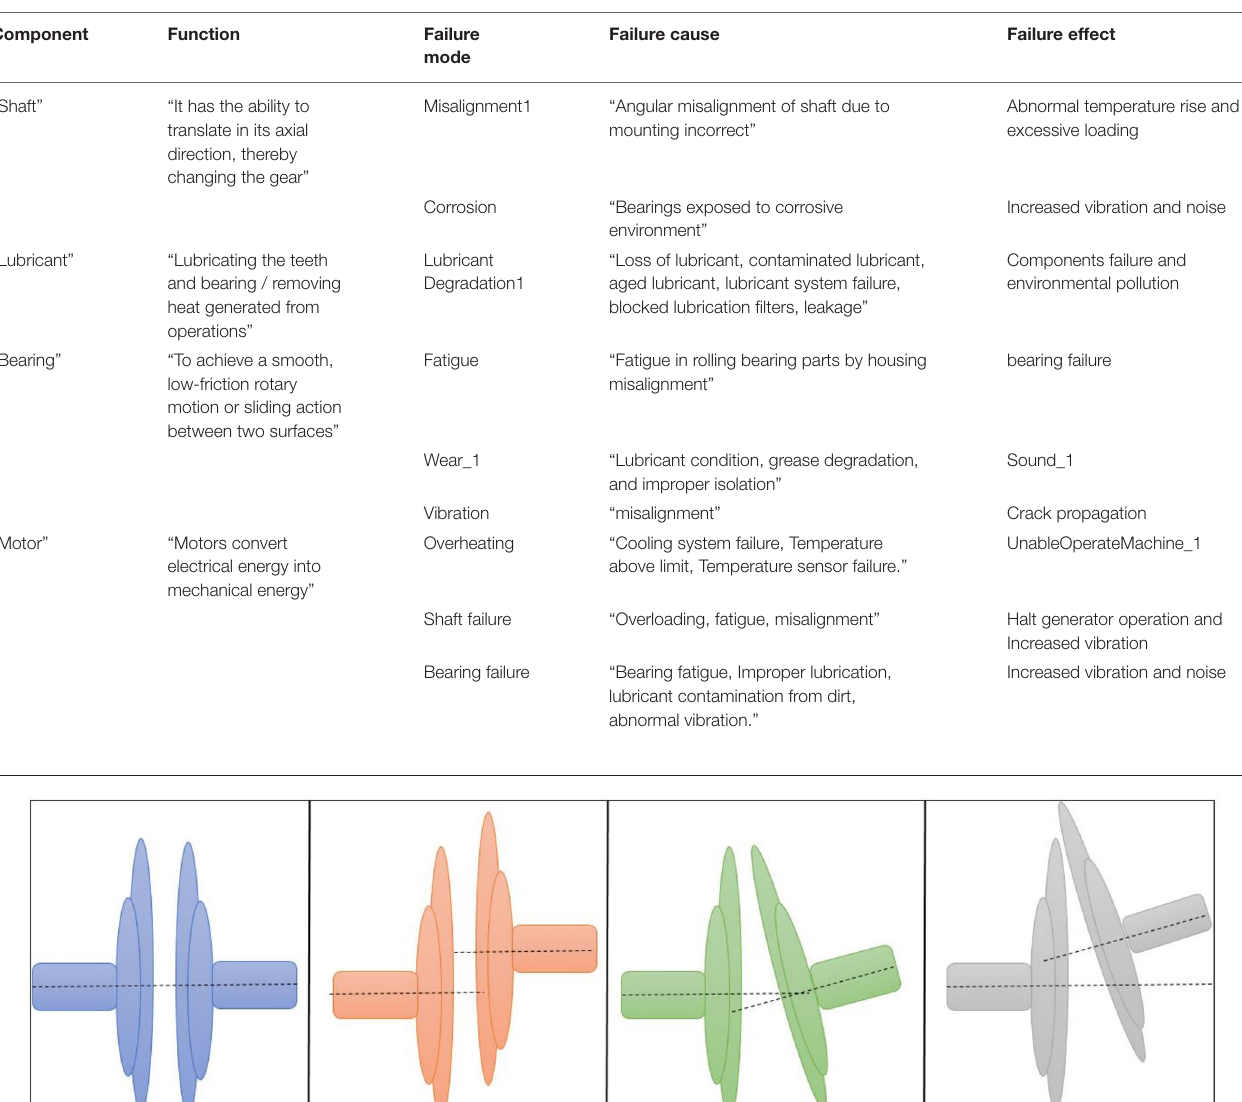
TABLE 7 | Function, failure mode, failure cause, and failure effect for test rig.